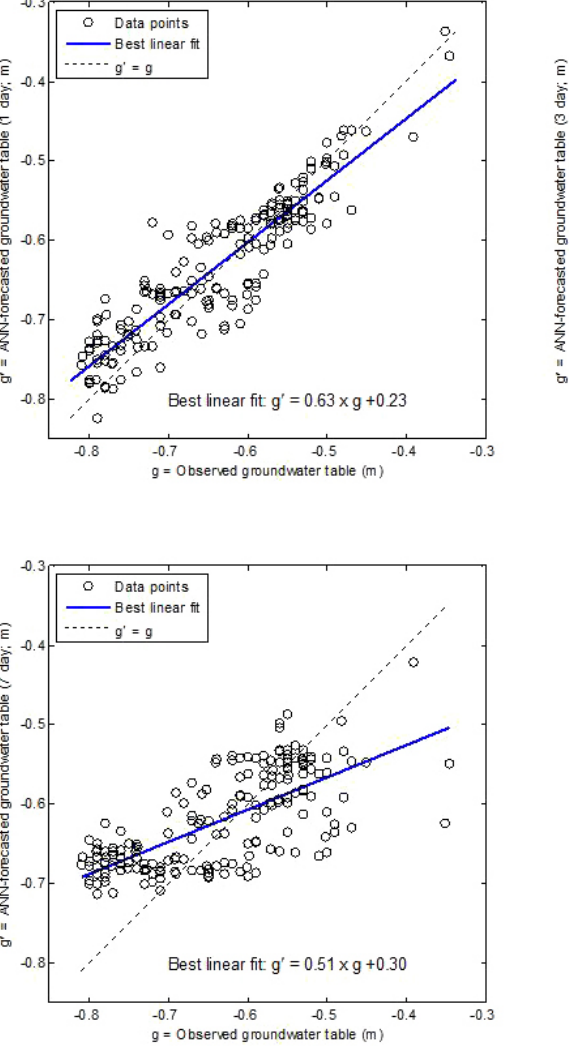
Figure 3. Scatter plots of observed and ANN-forecasted groundwater tables